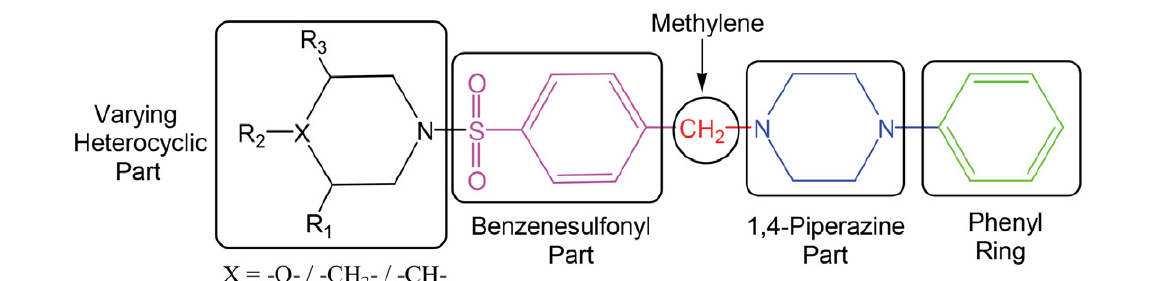
Figure 1. General structural parts of compounds 5 , 8 , 11 , and 14